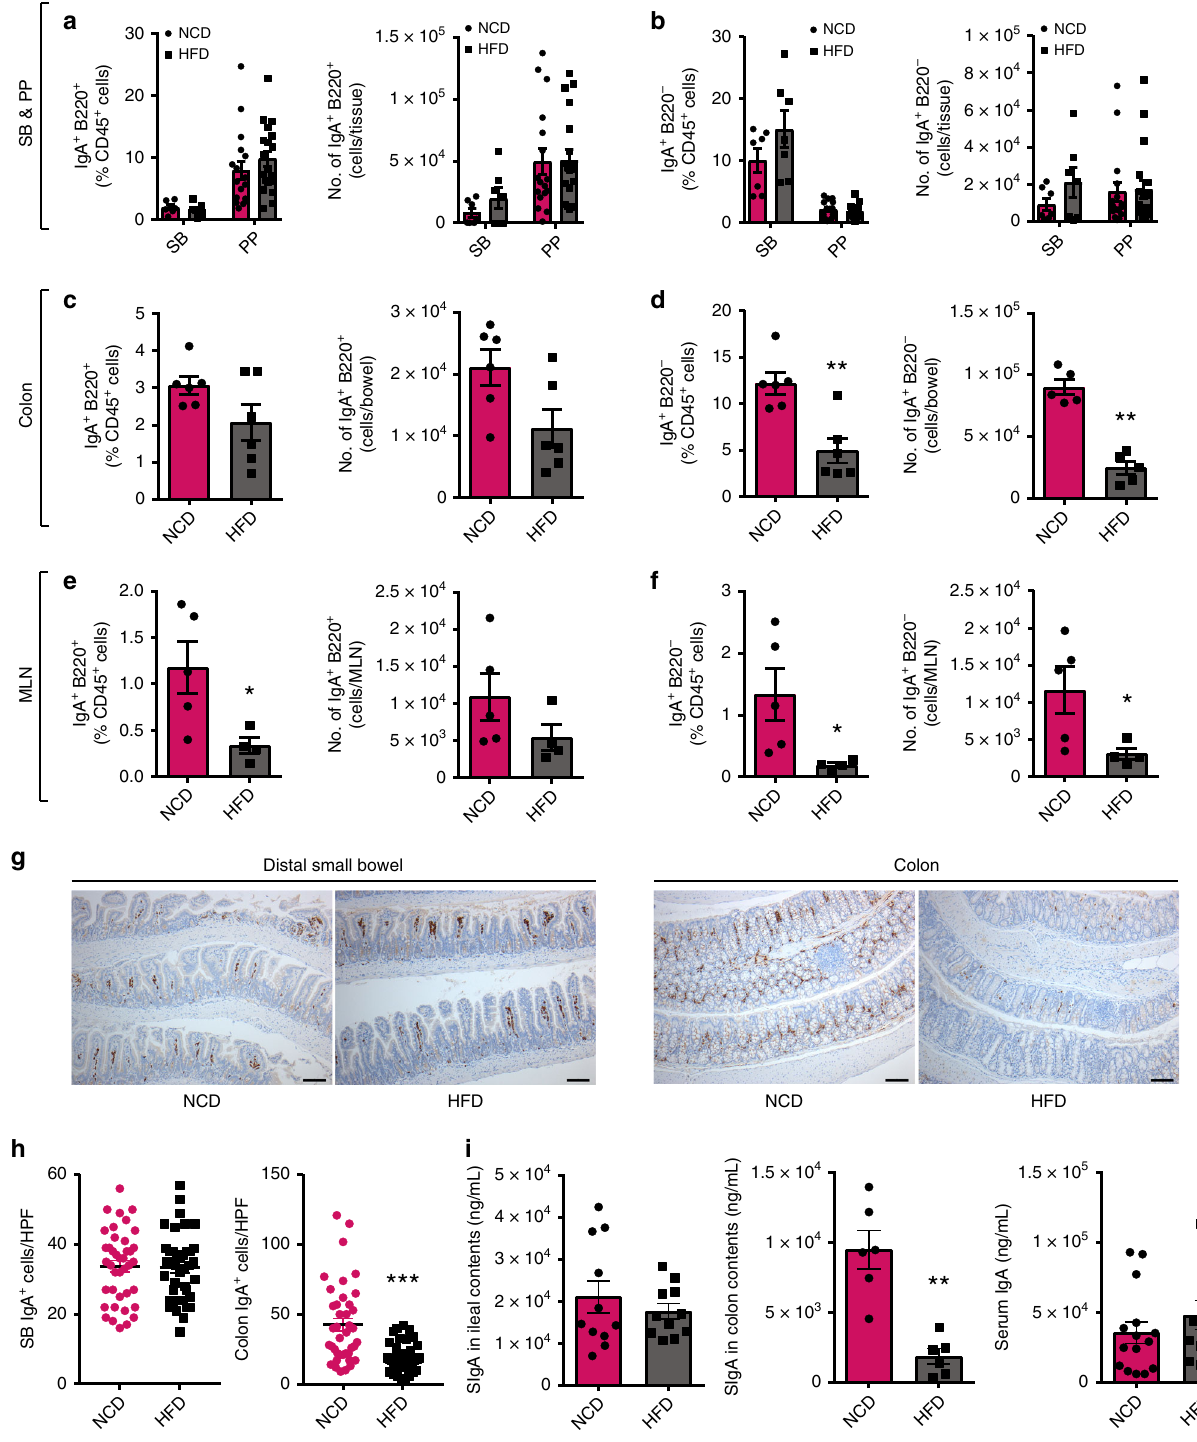
Fig. 1 The number of immunoglobulin A (IgA)-producing cells is reduced within the intestinal immune system of high fat diet (HFD)-fed mice. Frequency and absolute number of IgA-producing B cells (IgA + B220 + ) and plasma cells (IgA + B220 − ) within the a , b distal small intestine LP (SB) ( n = 7/group, 2 experiments), Peyer ’ s patches (PP) ( n = 17 – 19/group, 5 experiments), c , d colon LP ( n = 6/group, 2 experiments), and e , f colon draining mesenteric lymph nodes (MLNs) ( n = 4 – 5/group) in HFD-fed C57BL/6J mice after 14 weeks compared to normal control diet (NCD)-fed controls. g Representative staining of IgA + cells within the distal SB (left) and colon (right) in HFD- and NCD-fed mice after 14 weeks of diet (scale bar = 100 µ m). h Enumeration of IgA + cells per ×400 high power fi eld (HPF) in the distal SB (left) and colon (right) in NCD and HFD-fed mice ( n = 4/group, at least 10 HPF counted per mouse). i Concentration of secretory IgA (SIgA) within ileal contents (left) ( n = 11/group) and colonic stool (middle) ( n = 6/group), and IgA antibody titers in the serum (right) ( n = 15/group) of NCD and HFD wild-type (WT) mice. Data are means ± SEM. * denotes p < 0.05, ** denotes p < 0.01, and *** denotes p <